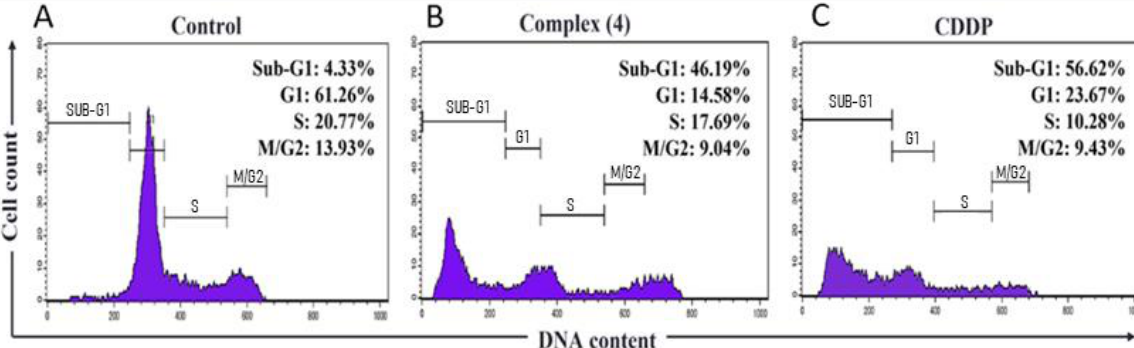
Figure 1. Cell cycle analysis by flow cytometry of MDA-MB-231 cells after 24 h of incubation and stained with propidium iodide (PI). Histograms representative of cell cycle progression show the percentage distribution of cells in different cell cycle phases. Cells with hypodiploid DNA content were measured by the sub-G1 fraction. ( A ) Control cells. ( B ) Cells treated with 2 × IC 50 of complex ( 4 ). ( C ) Cells treated with 2 × IC 50 of CDDP. Each experiment per sample was determined by recording 10,000 events. Data are representative of three independent experiments.